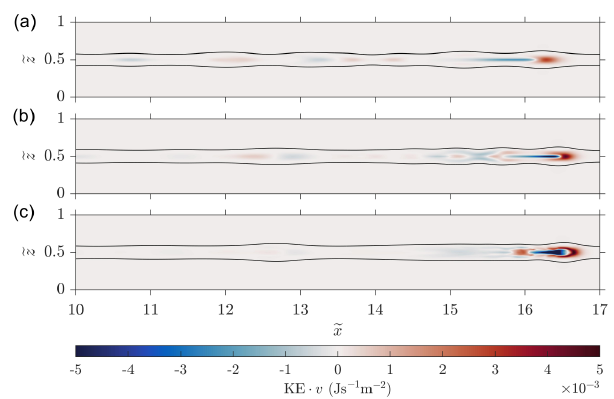
Figure 6. Span-wise kinetic energy flux density for case 10_1 at e t = 10 . 4 (t = 100s ) and e y = (a) 1 / 2, (b) 1 / 4, and (c) 1 / 8.